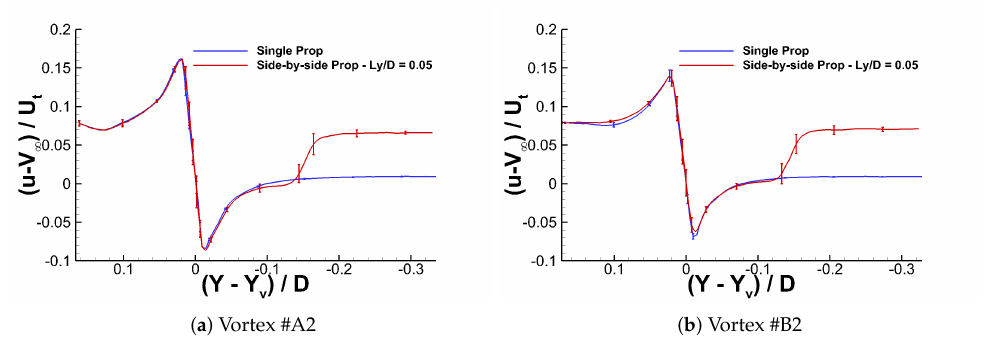
Figure 13. Comparison of the phase-averaged non-dimensional freestream velocity component profiles u extracted in correspondence with the tip vortices core locations ( X v , Y v ) for blade azimuthal angle ψ = 90 ◦ and advance ratio J = 0.8 , Re D = 1.96 × 10 6 , nad M t =